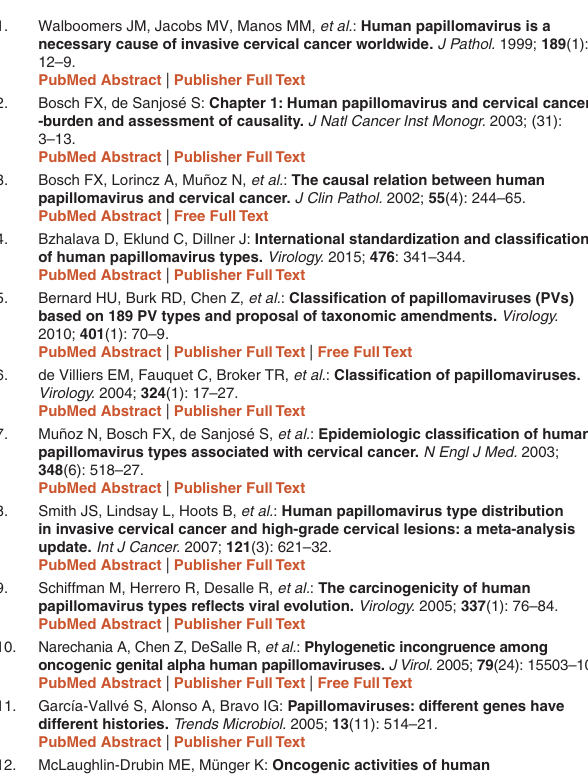
alignments of E6, E7, E1, E2, E4, E5, L1 and L2 amino acid sequences of alpha-HPV strains. • Figure S2: The balanced accuracy (y-axis) obtained from a leave-one-out cross validation for predicting risk cat- egory (HR vs LR) of alpha-HPV strains using BLO- SUM62 coding of amino acid sequences, of different positions (x-axis) E6 (A) and E7 (B). Zero-accuracy was assigned to regions surrounded with low confidence alignment.